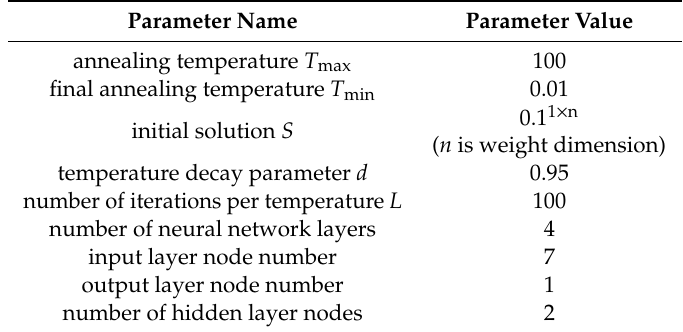
Table 2. List of simulated annealing and error back-propagation neural network (SA-BP) algorithm parameter settings.